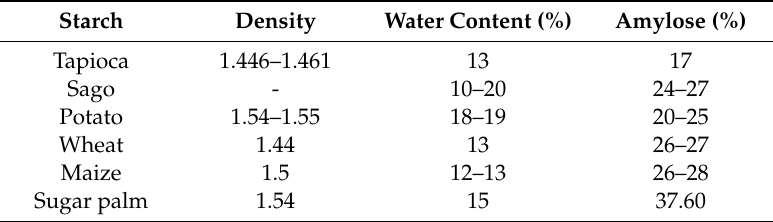
Table 1. The composition of sugar palm starch and various starches [38].